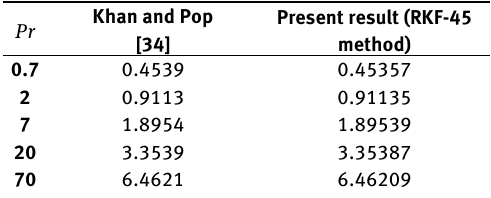
Table 2: Comparison of the result for Nusselt number − θ (cid:48) (0) in the absence of We , θ w , R , B , D .